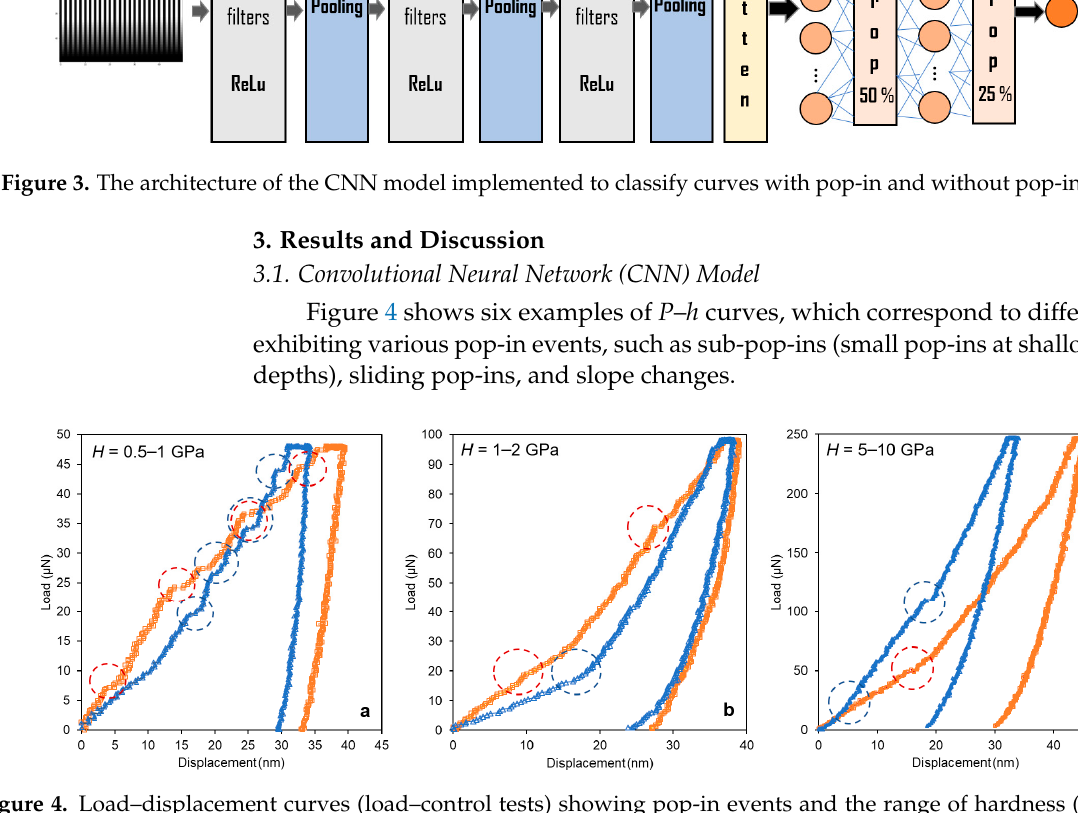
Figure 4. Load–displacement curves (load–control tests) showing pop-in events and the range of hardness ( H ) values. ( a ) sub-pop-ins in Al alloys; ( b ) slope changes and sliding pop-ins in Al alloys; ( c ) slope changes and pop-ins in ceramic coatings. In each plot, each curve represents a different material that exhibits similar pop-in event features.